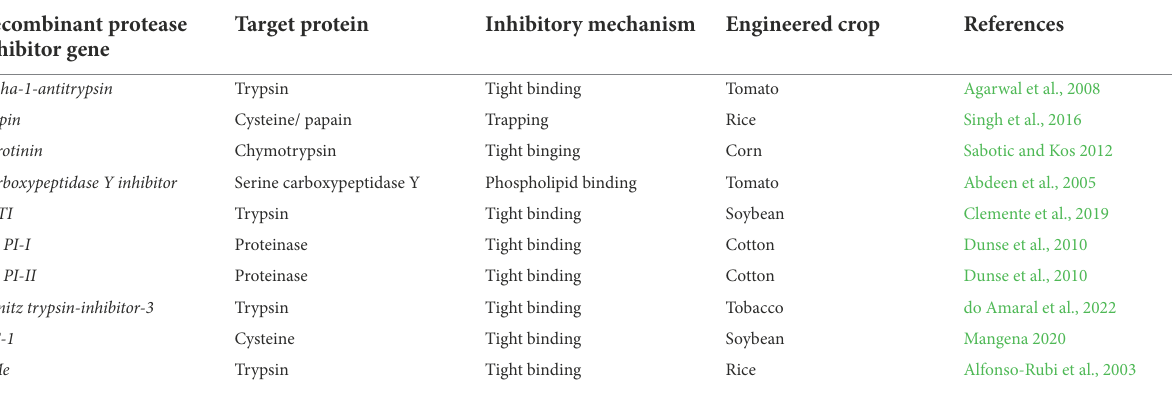
TABLE 3 Recombinant protease inhibitor genes used to engineer plants for biotic and abiotic stress resistance originating from plants, bacteria, and fungi. Recombinant protease inhibitor